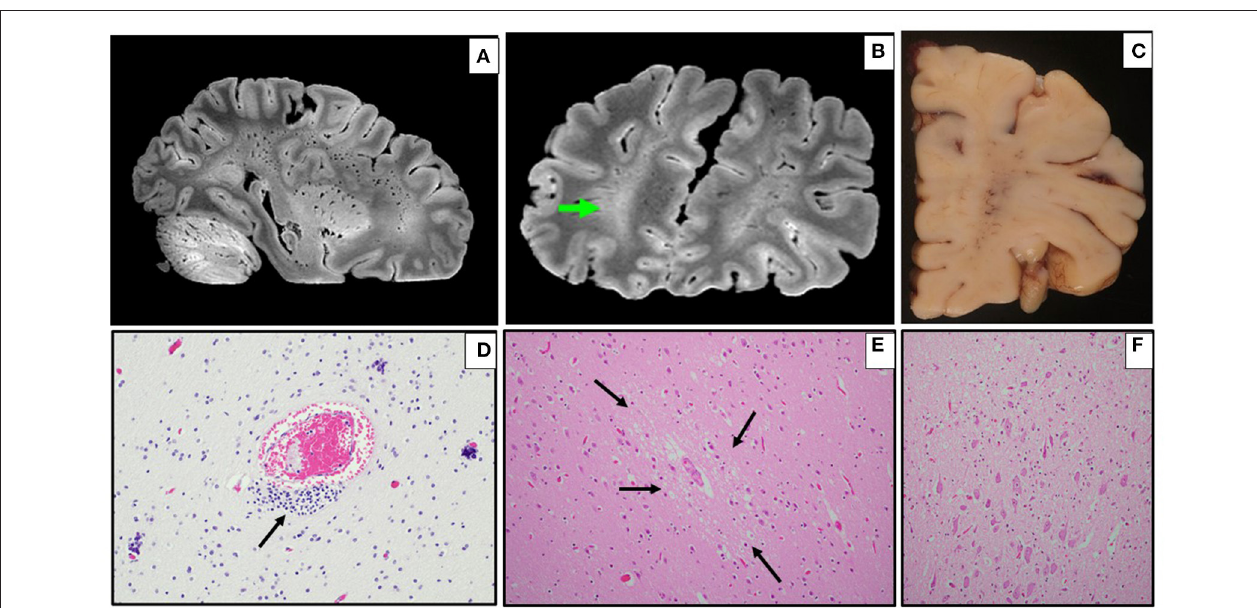
FIGURE 1 | Ex vivo MRI and neuropathology in infants (Cases 1–4). (A,B) Sagittal (A) and coronal (B) multi-echo gradient-echo MRI with diffuse exaggeration of perivascular spaces, and broad areas of white matter signal hyperintensity [green arrow in right frontal lobe, per radiological orientation convention (patient’s right on the left of the screen) (B) ] (Case 1). (C) Coronal section of right frontal lobe showing prominent white matter vasculature (Case 1). (D) Multifocal perivascular mineralization in frontal white matter, as well as residual immature cells (arrow) (H&E, 200x) (Case 1). (E) Multifocal perivascular vacuolization (arrows) and gliosis in gray matter (H&E, 200x) (Case 4). (F) Sparse parenchymal inflammation in brainstem (H&E, 100x) (Case